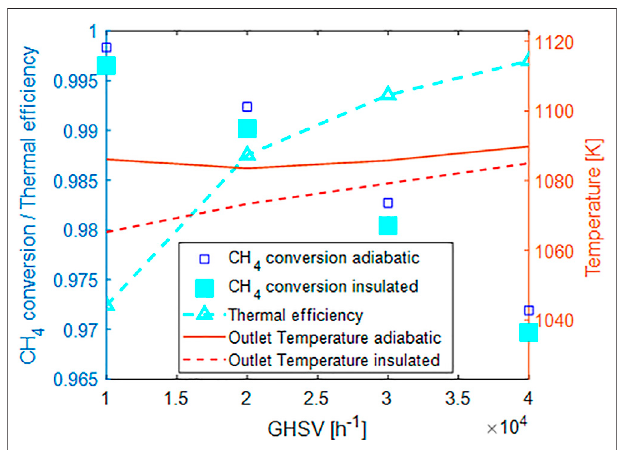
FIGURE 10 | Effect of 1 cm thermal insulation layer on the process performances:blue squares CH 4 conversion in the adiabatic unit, cyan squares CH 4 conversion in insulated unit, cyan triangles thermal ef fi ciency, solid line outlet temperature adiabatic, dashed line outlet temperature insulated.